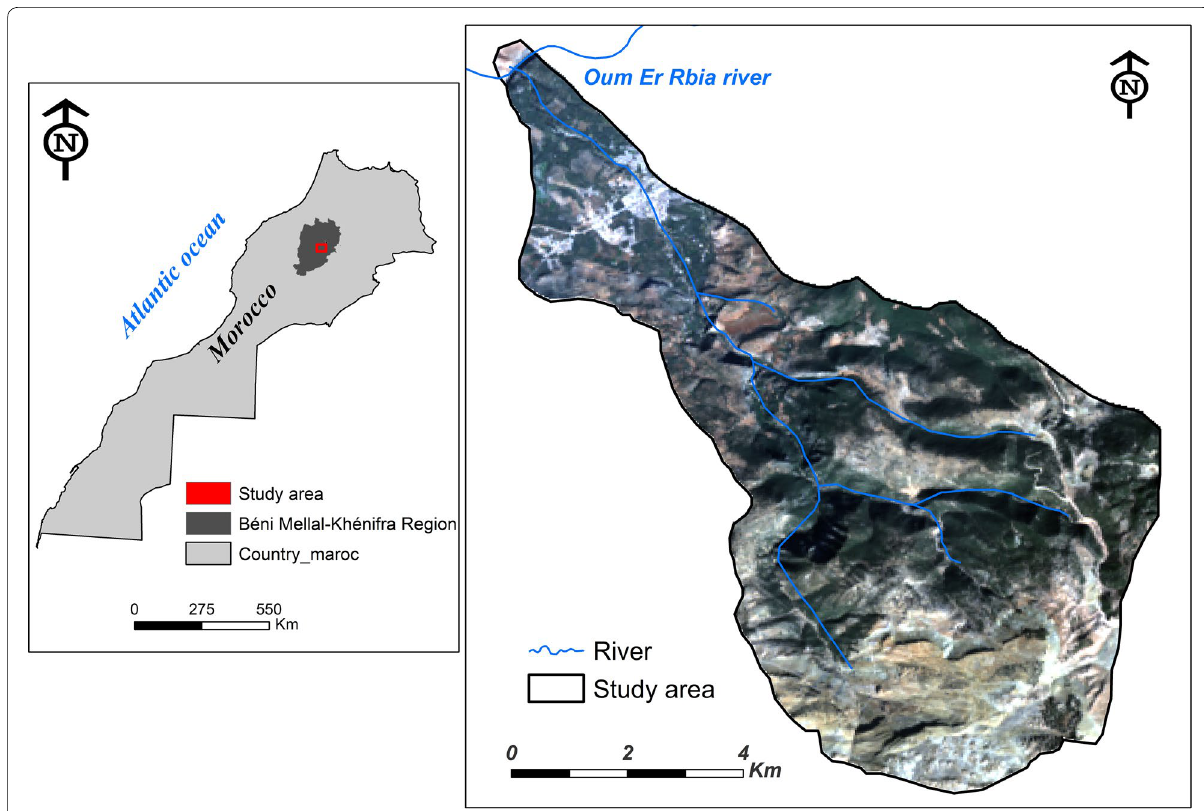
Fig. 1 Location of the study